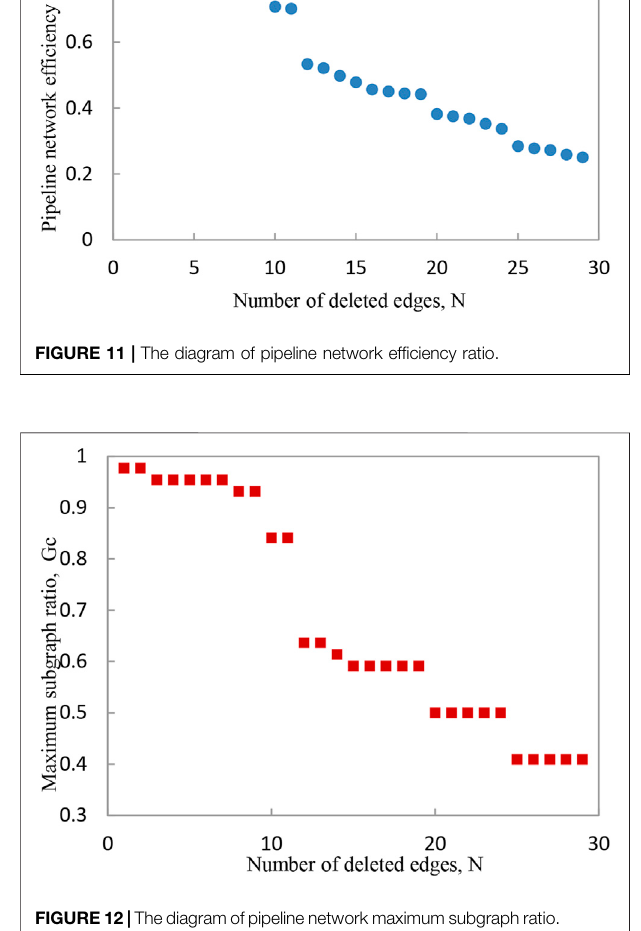
FIGURE12 | Thediagram ofpipeline networkmaximum subgraph ratio.